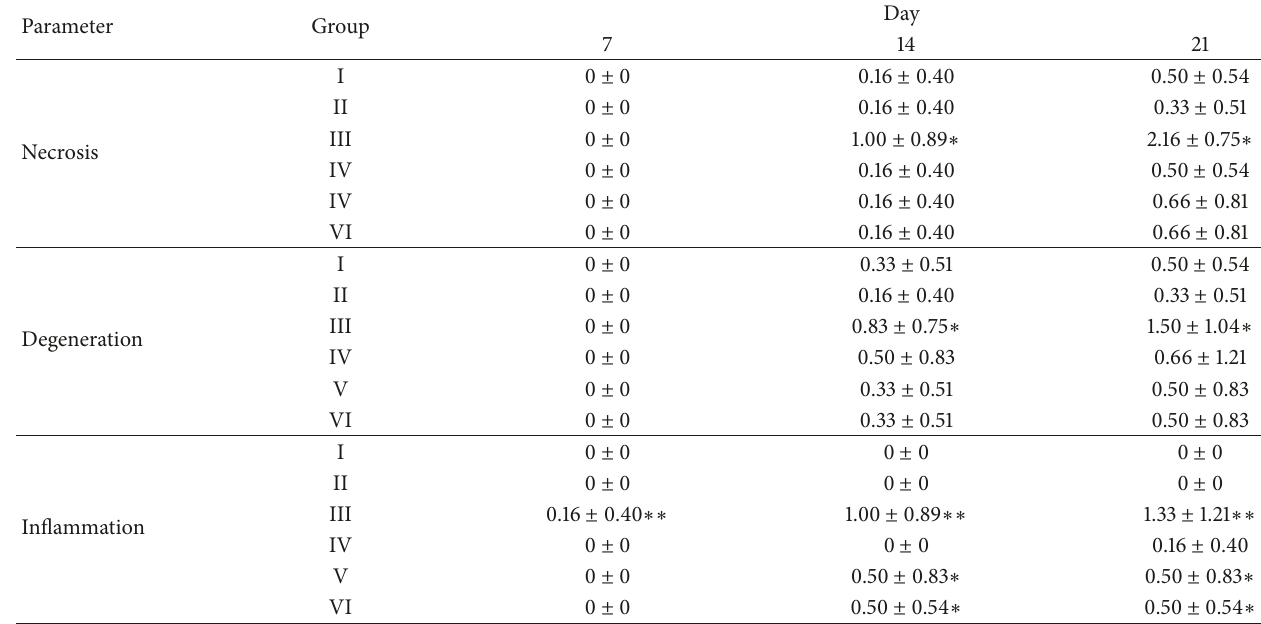
Table 9: Effects of 5% SAP on the kidney histopathology of broiler chickens fed a diet naturally contaminated with AF at 7, 14, and 21 days of